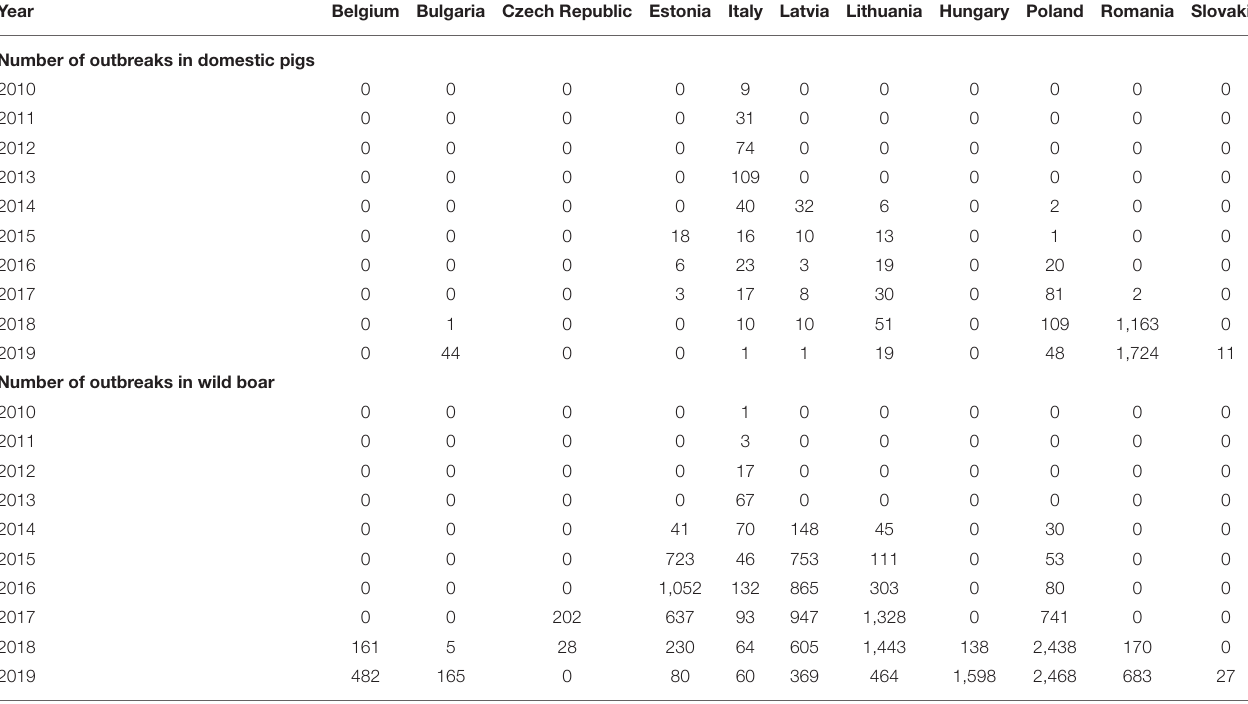
TABLE 1 | Number of outbreaks of with ASF in domestic pigs and in wild boar per country and per year in the European Union during years 2010–2019. Year Belgium Bulgaria Czech Republic Estonia Italy Latvia Lithuania Hungary Poland Romania